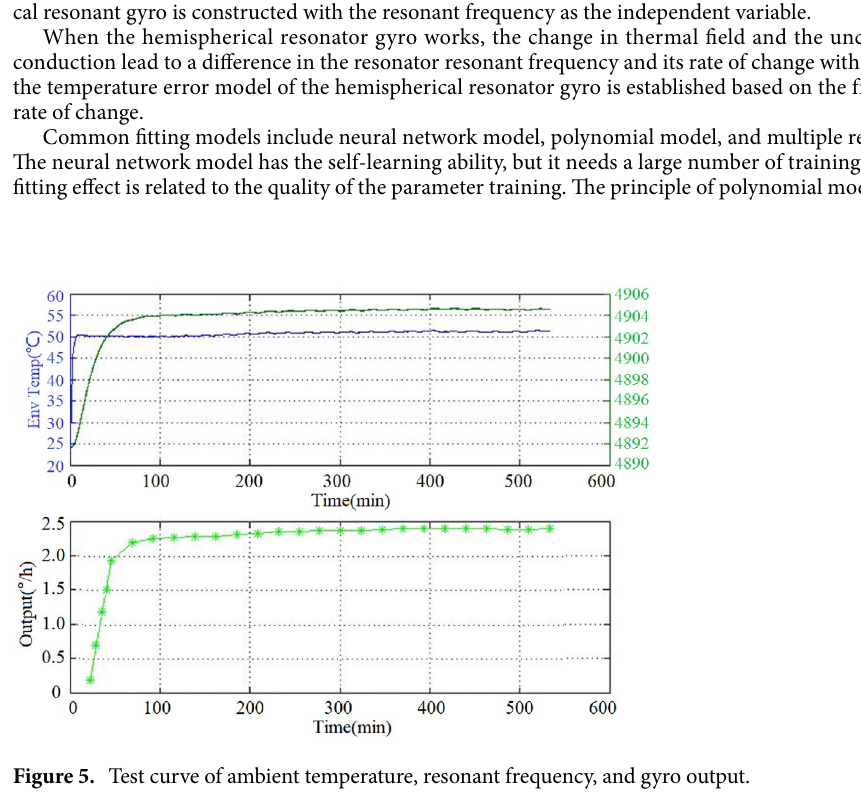
Figure 5. Test curve of ambient temperature, resonant frequency, and gyro